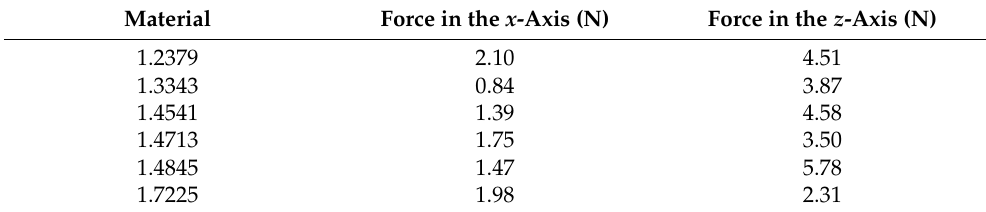
Table 8. Measured forces at the traverse speed 40 mm/min on selected steels.